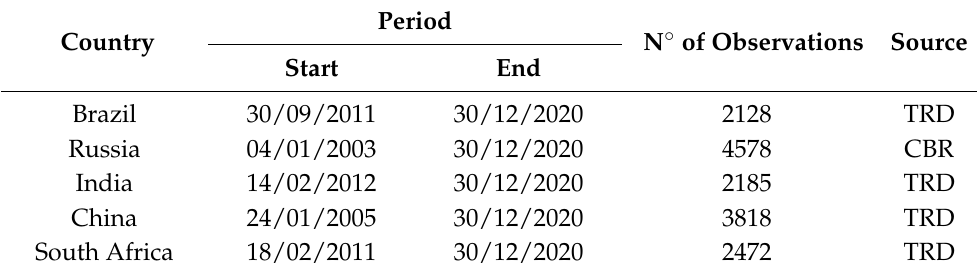
Table 1. Dataset